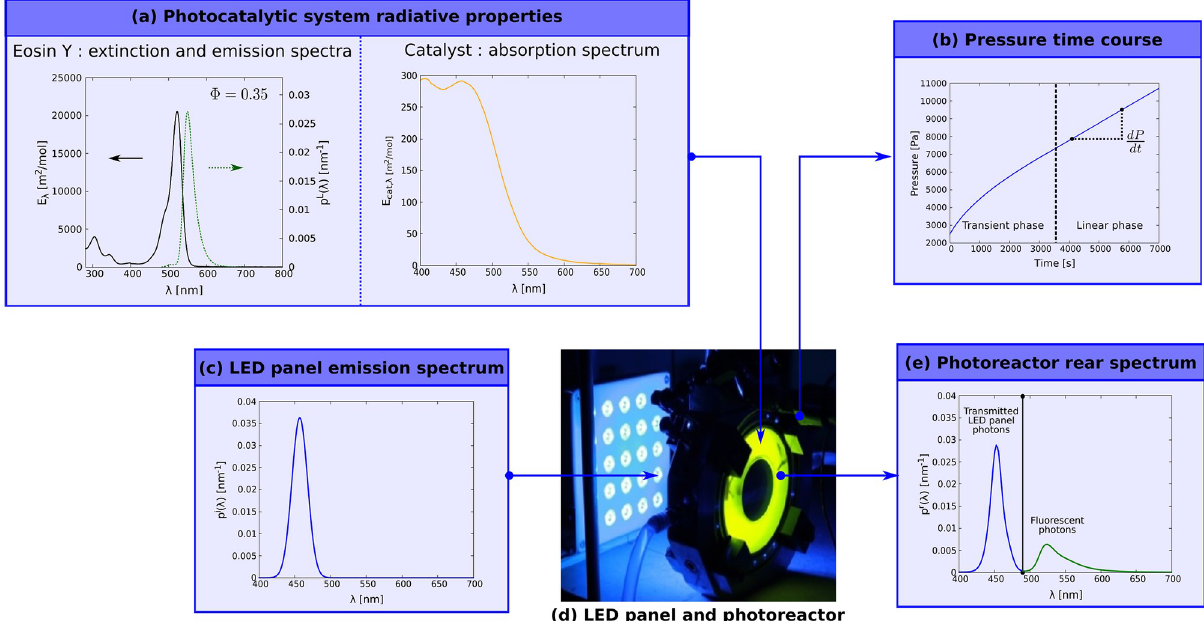
Fig 5. Materials. (a) Photocatalytic system radiative properties—left: Eosin Y (24 μ M) UV-visible molar extinction cross-section E λ , fluorescence emission spectrum p L ( λ ) and quantum yield F = 0.35 in a mixture of triethylamine (10% vol.) in water at pH 10.5 [18, 21]; right: Catalyst (1.66 mM) molar absorption cross section in methanol. UV-visible spectra were obtain using a Shimadzu UV-visible UV-160 A spectrophotometer and emission spectra from a Shimadzu RF-1501 spectrofluorimeter [18]— (b) Example of experimental pressure time course presenting transient and linear regimes with the slope dP in the linear regime— (c) wavelength probability density function incident source i.e . LED panel emission spectrum p i ( λ )— (d) dt photograph of the photoreactor containing the fluorescent photocatalytic system illuminated by the blue LED panel— (e) Example of the wavelength probability density function spectrum p r ( λ ) of photons measured at the rear of the reactor composed of transmitted LED panel photons and fluorescent